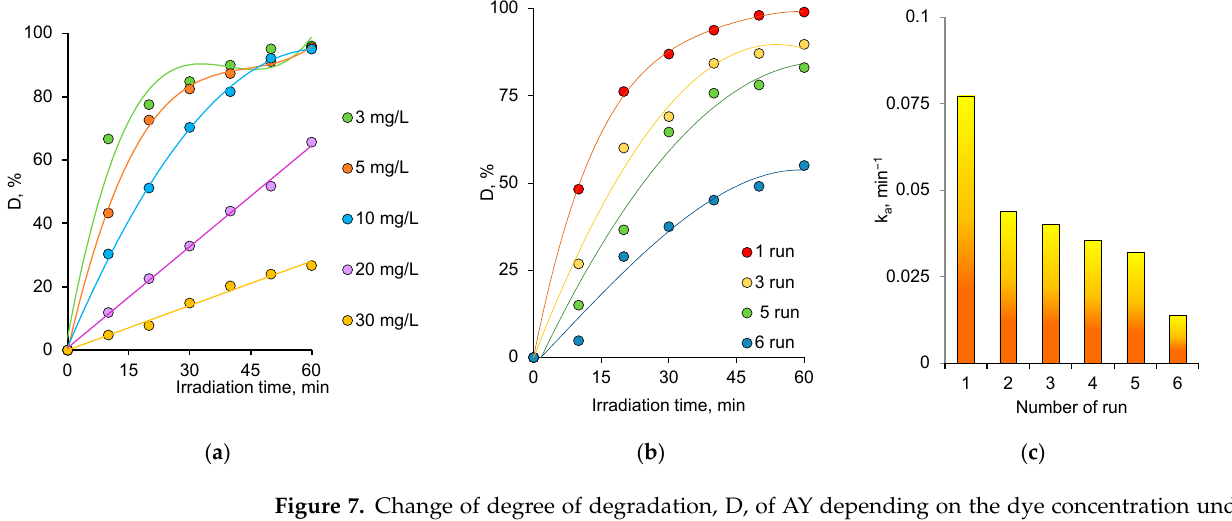
Figure 7. Change of degree of degradation, D, of AY depending on the dye concentration under UV-light ( a ). Variation of D ( b ) and reaction rate constant, ka ( c ) of AY in repeated uses of ZnO catalyst over 6 consecutive test cycles.